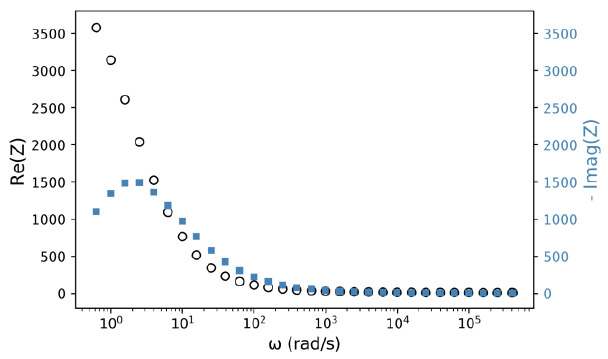
Fig.3: Resistance (Black) and reactance series equivalents (Steel Blue) of the EEI versus frequency for AISI 304 stainless steel electrode polished with sandpaper #180 in NaCl 0.9% solution. Overpotential applied = 10 mV.